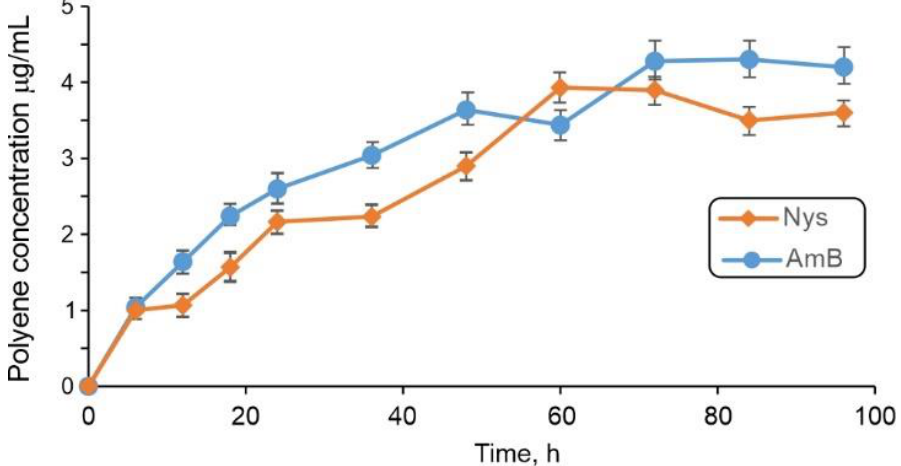
Figure 2. Release of polyenes (Nys and AmB) in simulated sweat from mcl-PHA films NYS-9 and AMB over 4 days at 37 ◦ C. Values are means of two independent experiments ± standard deviations